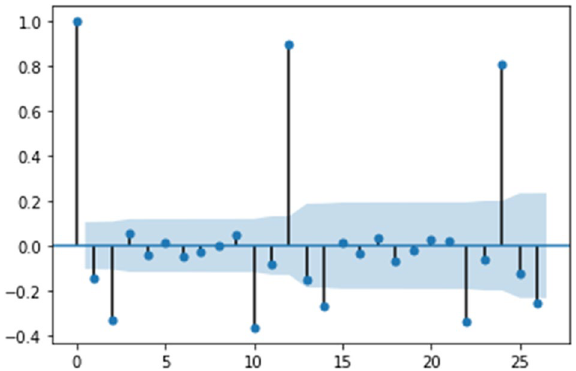
Fig. 1 Autocorrelation function for US e-trade volume from 1 to 25